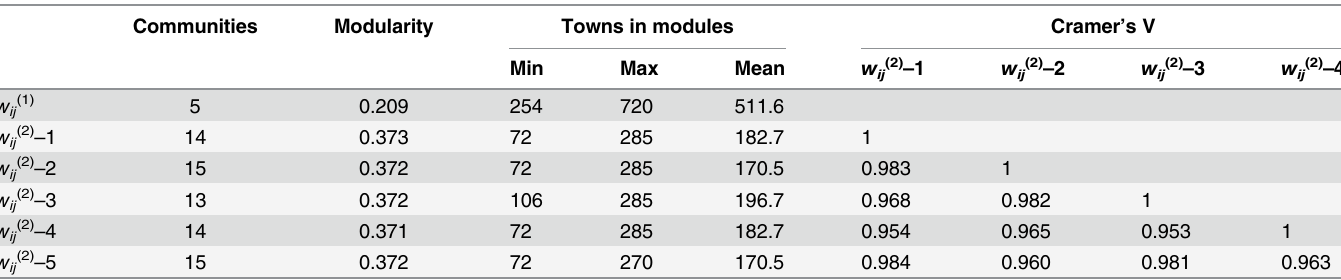
Table 2. Network